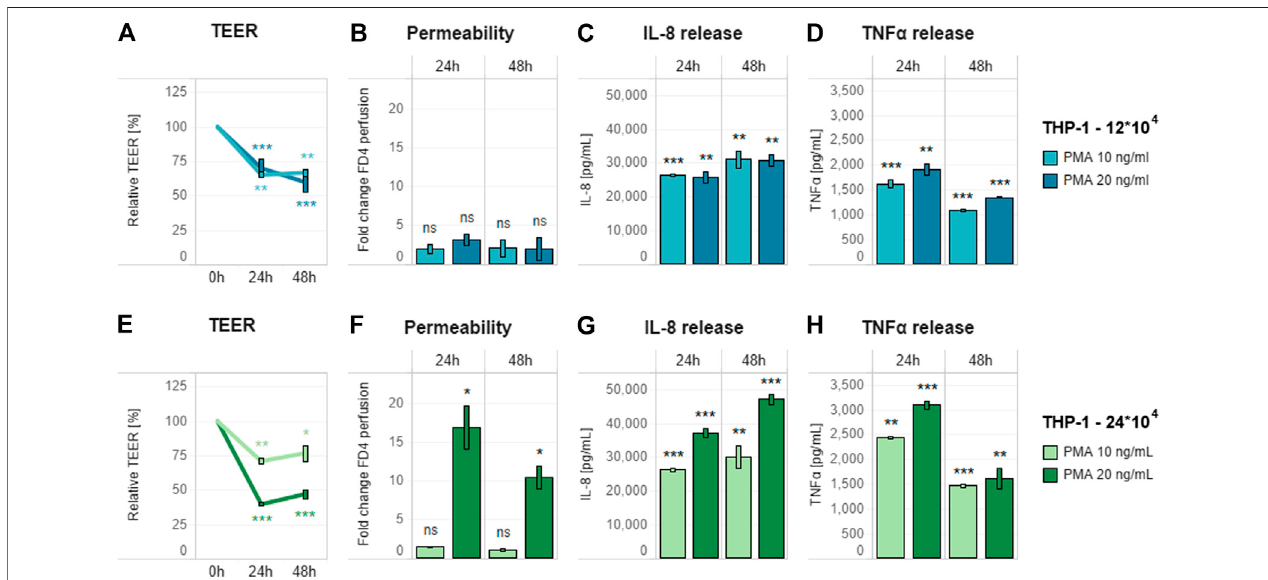
FIGURE 3 | Effect of pro-in fl ammatory stimulation on optimized triculture. Pro-in fl ammatory effect of 10 ng/ml LPS added basolaterally to a triculture containing (A – D) 12 × 10 4 and (E – H) 24 × 10 4 THP-1 cells in 400 µl of cell culture medium in the basolateral compartment. (A,E) TEER (B,F) membrane permeability, and (C,D,G,H) cytokinerelease(IL-8andTNF α ,respectively)ofthetriculture.ForeachTHP-1seedingcondition,differentPMAconcentrations(10and20 ng/ml)weretested for optimizing the triculture response. TEER values are represented in percentage; zero-hour treatment was used as the reference (100%). Permeability is expressed as fold change over the untreated control without LPS. Data are presented as the average of three technical replicates with the corresponding standard deviations. Statistical differences between the LPS- and PMA-treated cultures and the control culture without the compounds (with 12 × 10 4 THP-1 cells) were determinedby atwo-tailed t -test. * p ≤ 0.05;** p ≤ 0.01; *** p ≤ 0.001;ns, p > 0.05.Abbreviations: PMA, phorbol 12-myristate;TNF, tumor necrosisfactor; IL, interleukin; CTL,